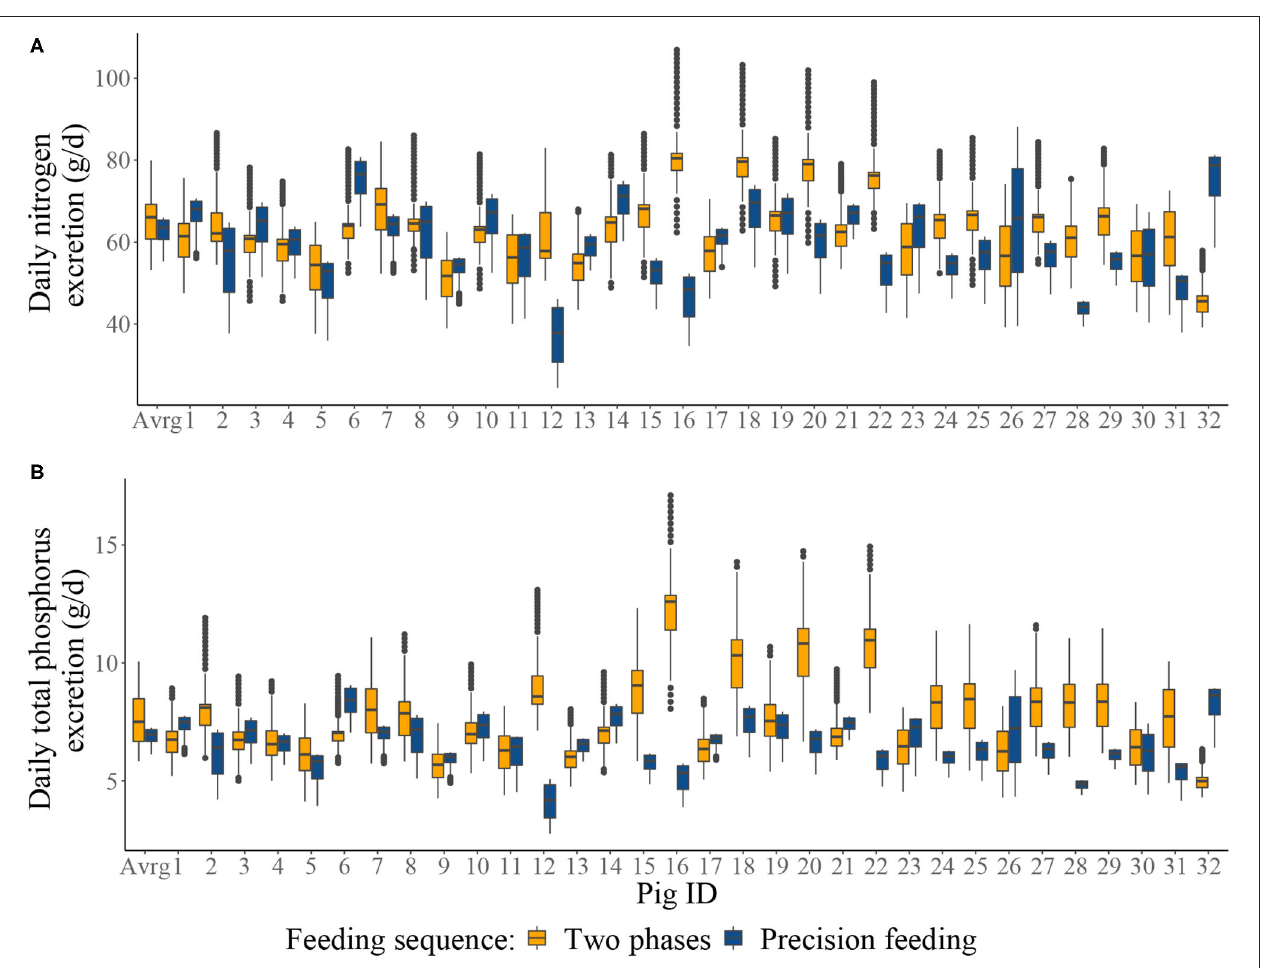
FIGURE 4 | Boxplots of: (A) the individual daily nitrogen excretion (g/d); and (B) the individual daily total phosphorus excretion from two-phase feeding strategy or precision feeding strategy offered either to the average pig (Avrg) or each of the thirty-two pigs in the population (1–32). For a detailed description of the simulated scenarios, see section Simulated Feeding